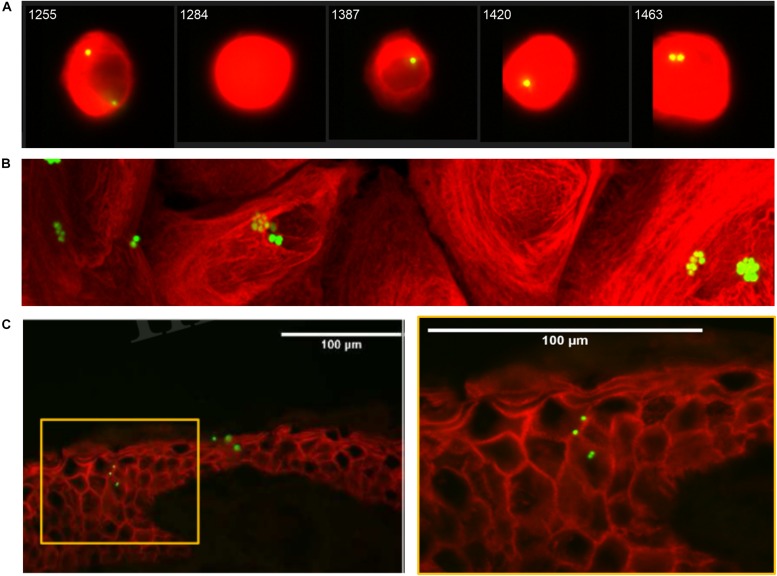
Internalization of GFPS. aureus by Normal Human Epidermal Keratinocytes (NHEK). (A) Representative Amnis® Image Stream Analysis of NHEK co-cultured with 107 CFU/ml FITCLiSA for 1 h at 37°C, then treated for 30 min with 2% penicillin/streptomycin (P/S) to eliminate extracellular bacteria and cultured for a further 4 h prior to staining and analysis. Red stain: Alexa Fluor® 647 mouse anti-human cytokeratin 14/15/16/19. Green stain: FITCS. aureus.
(B) Representative confocal microscopy 2D image of NHEK after co-culture with 107 CFU/ml GFPS. aureus for 1 h at 37°C. (C) Representative immunofluorescent staining of healthy human skin explant after 3 h infection with GFPS. aureus (107 CFU/ml) at 37°C. Red: anti-rabbit claudin-1 antibody. Green: GFPS. aureus. Yellow box (left panel) highlights area of right panel magnified. All data are representative of three independent experiments. Images taken at 40× magnification. Scale bars represent 100 μm.